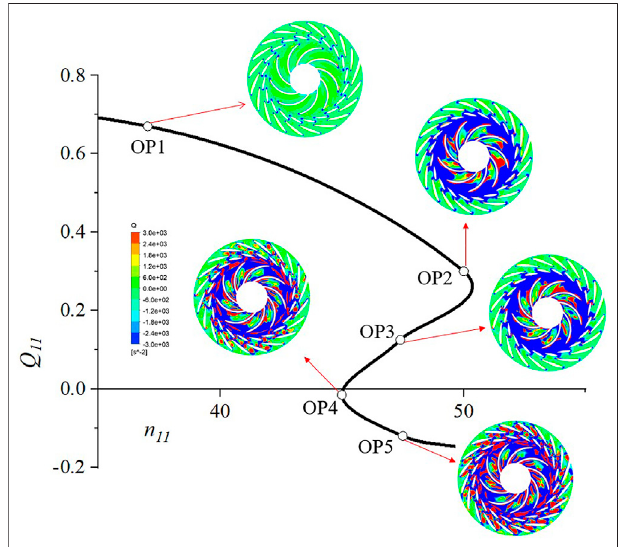
FIGURE 6 | Results for Q -criterion